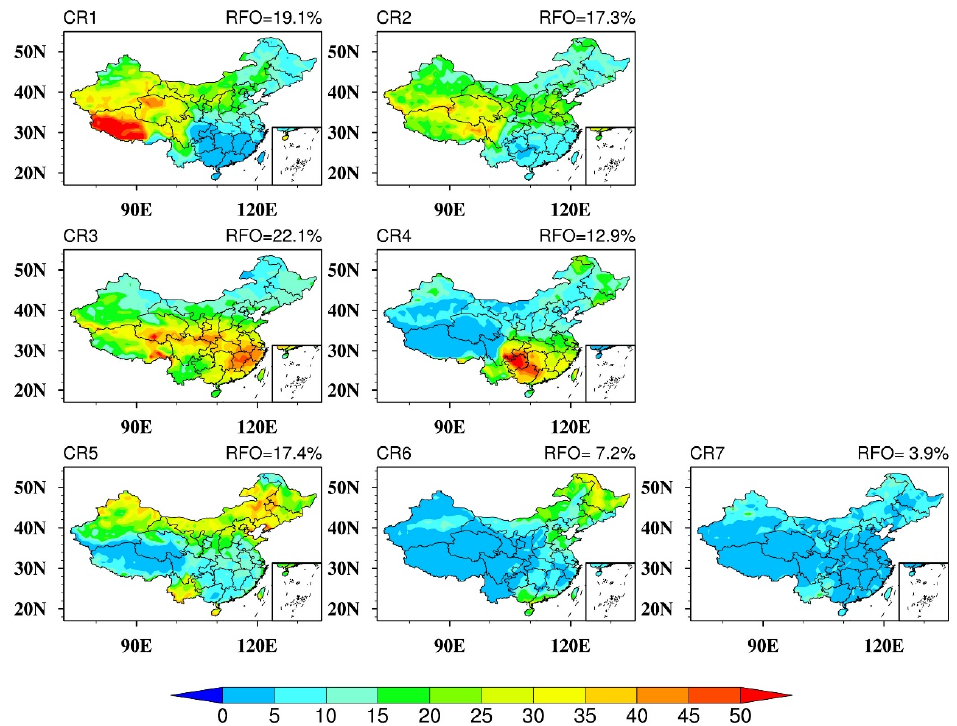
Figure 2. The spatial distribution of the relative frequency of occurrence (RFO) for CR1-CR7. The RFO in each 1° × 1° grid for a cloud regime is calculated by dividing the pixel counts of successful retrieval in the regime by the total pixel counts of all regimes. The total RFOs of the regimes are also given in the subtitles of each panel, which are obtained by dividing the pixel counts of all grids over China that belongs to the regime by the total pixel counts of all grids.